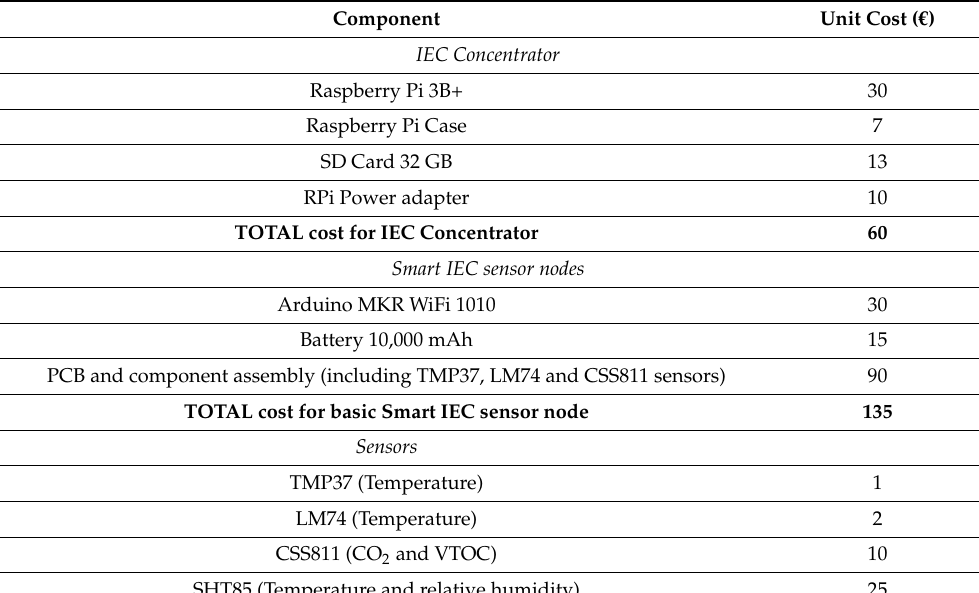
Table 4. Total cost for the IEQ monitoring system components.